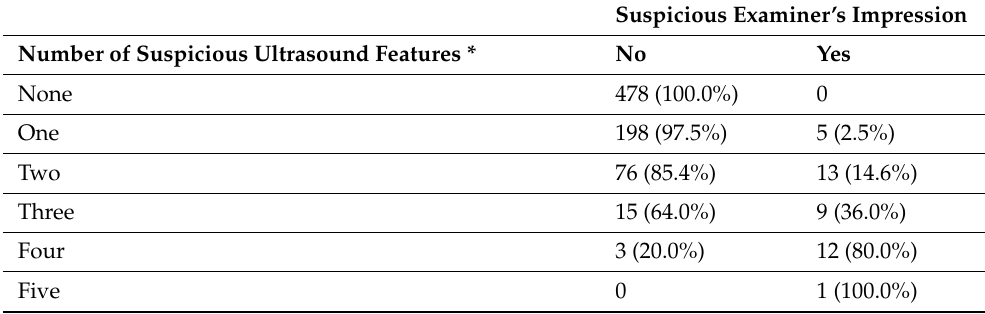
Table 4. Distribution of a number of suspicious ultrasound features and examiner’s subjective impression. Suspicious Examiner’s